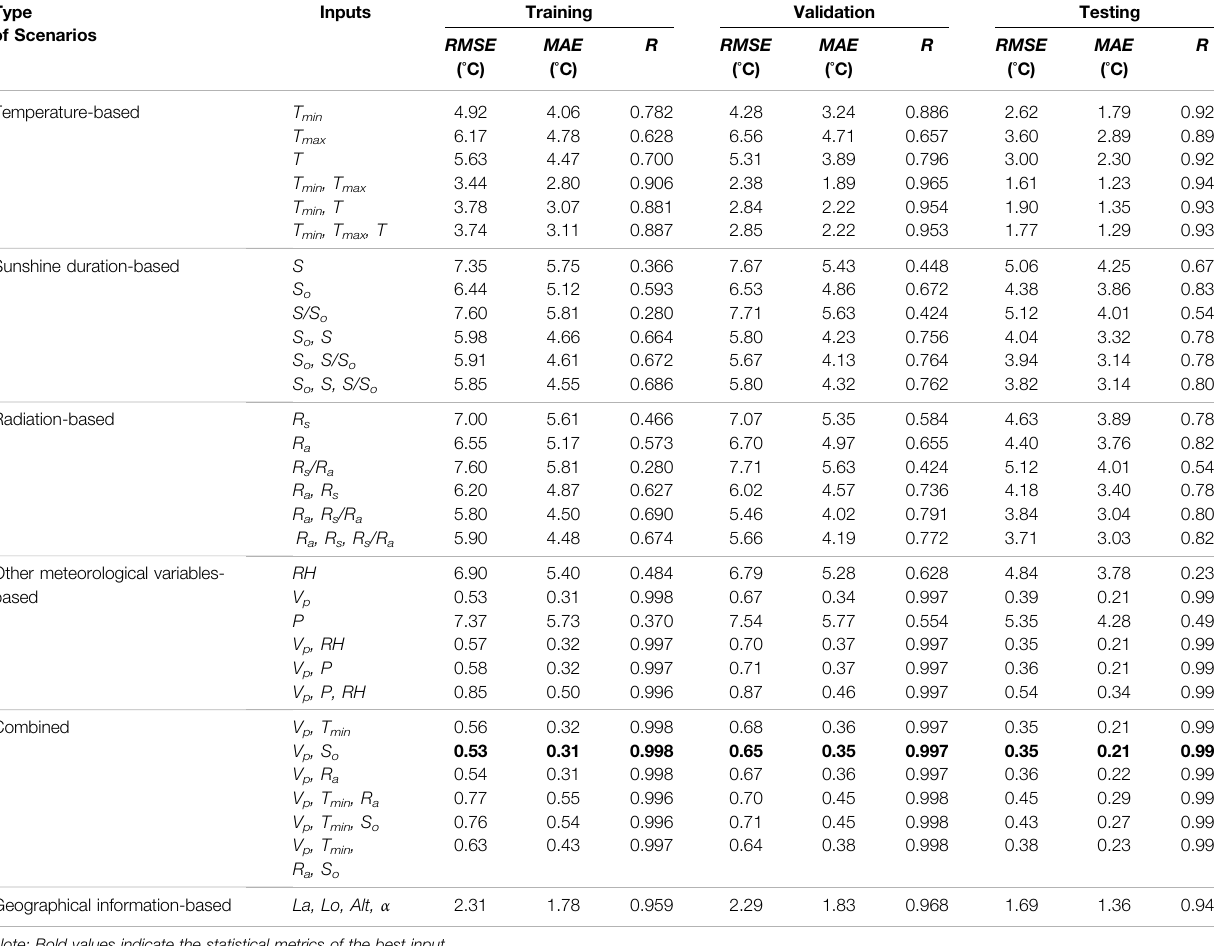
TABLE 3 | Statistical indices of T dew estimates from the RF model for the training, validation, and testing phases. Type of